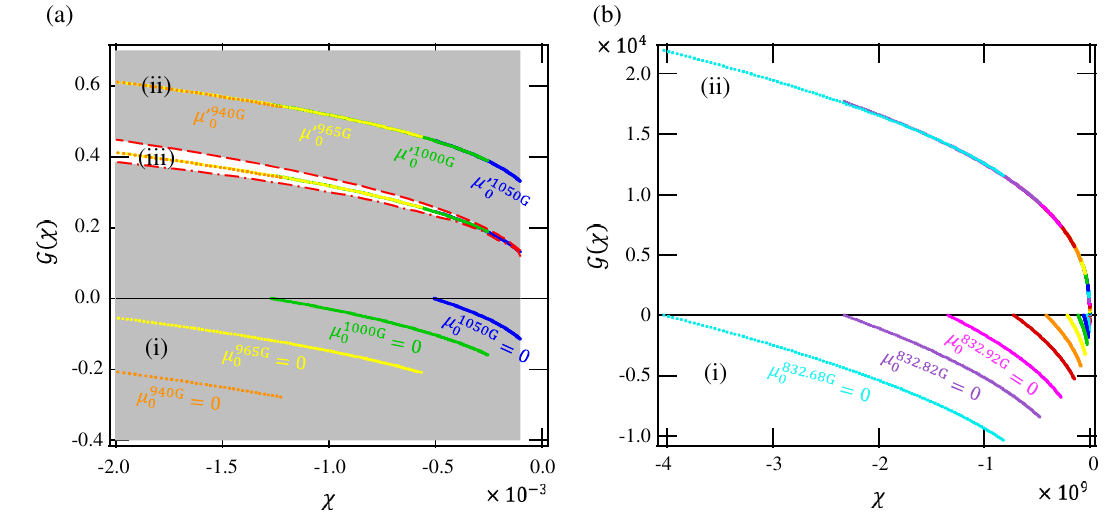
FIG. 4. Construction of dimensionless function G ð χ Þ . The different colors indicate the contributions of data taken at each magnetic field for the Feshbach resonance. (a) Around the BCS limit. The dash-dotted red curve and the dashed red curve indicate the lower and upper limits of G ð χ Þ . The gray areas correspond to the forbidden area for G ð χ Þ . (i) Unconnected data with μ B 0 ¼ 0 for all data. (ii) Connected data located in the forbidden area. (iii) Connected data for which the offset value is tuned appropriately. (b) Around the unitarity limit. (i) Unconnected data with μ B 0 ¼ 0 for all data. (ii) Connected data for which the offset value is tuned